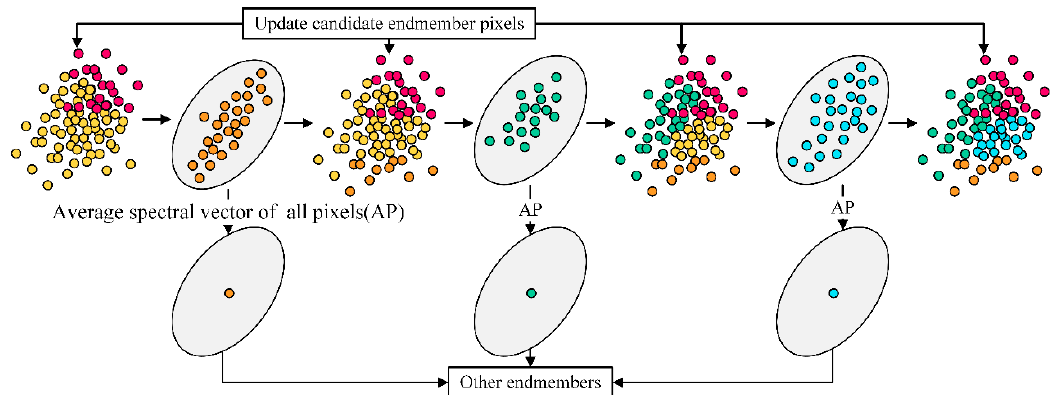
Figure 6. Extraction other endmembers. In each step, the candidate endmember pixels with similar spectral information were averaged, and then these selected pixels were removed from the candidate endmember pixel sets. This step was repeated until U i v = φ , U i o = φ or the number of extracted endmembers exceeded a set